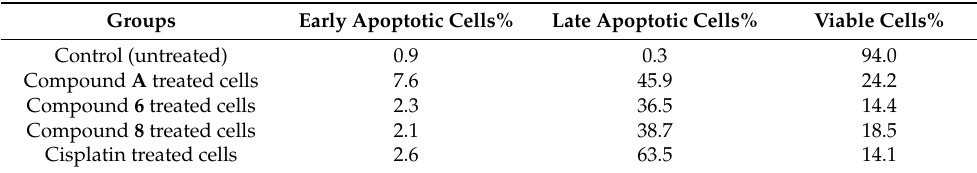
Table 2. Percents of typical quadrant analysis of Annexin V FITC/Propidium iodide flow cytometry of A549 cells treated with compounds A , 6 , 8 , and cisplatin.